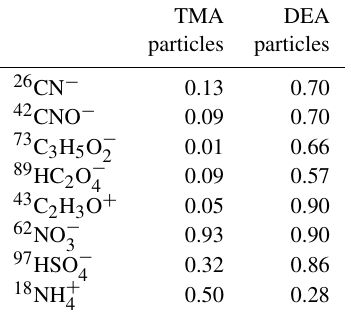
Table 2. The linear correlations ( r 2 ) between secondary-ion- containing amine particles within TMA- and DEA-containing par- ticles. TMA